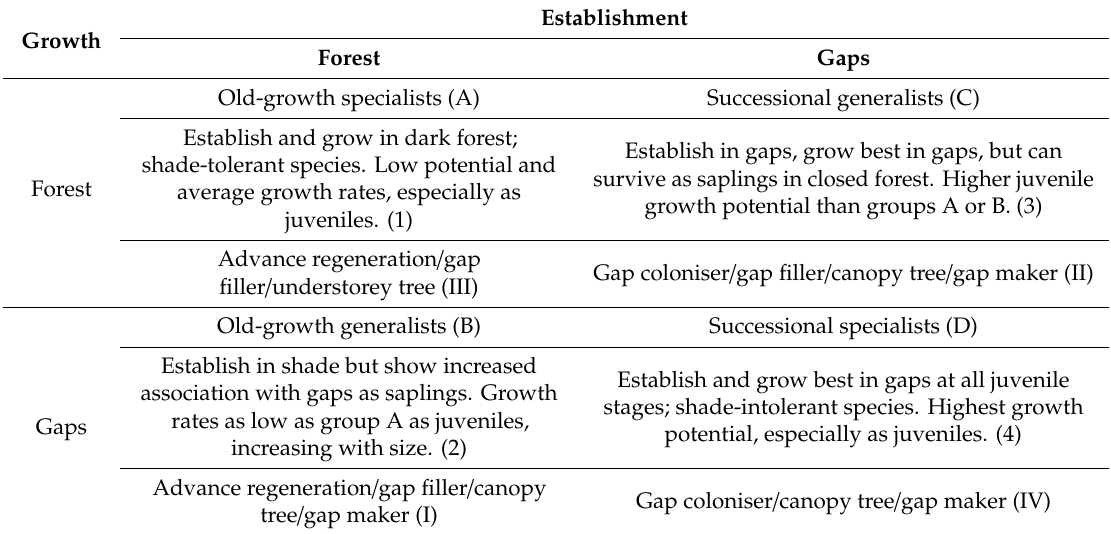
Table 2. The types of successional trajectories based on tree regeneration mode in forest gaps. Chazdon’s et al. [124] successional trajectories (Clark and Clark’s [139] species groups A–D) correspond roughly to Whitmore’s [140] species groups 1–4, having increasing “pioneer index”, Yamamoto’s [141] four major types of tree regeneration mode in gaps (numbered I–IV) and Petrere’s et al. [90] four community types. Modified from Franklin